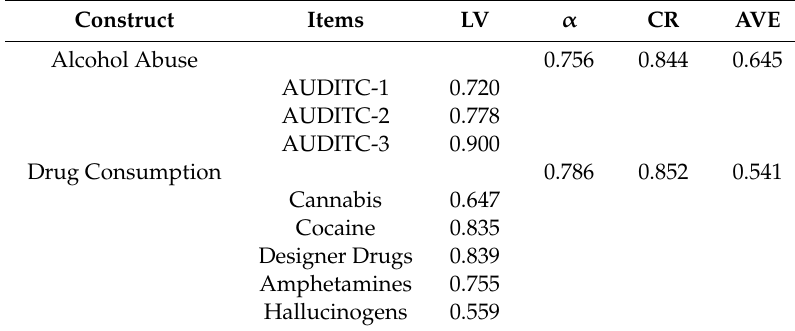
Table 6. Hypotheses testing for direct and mediating relationships.